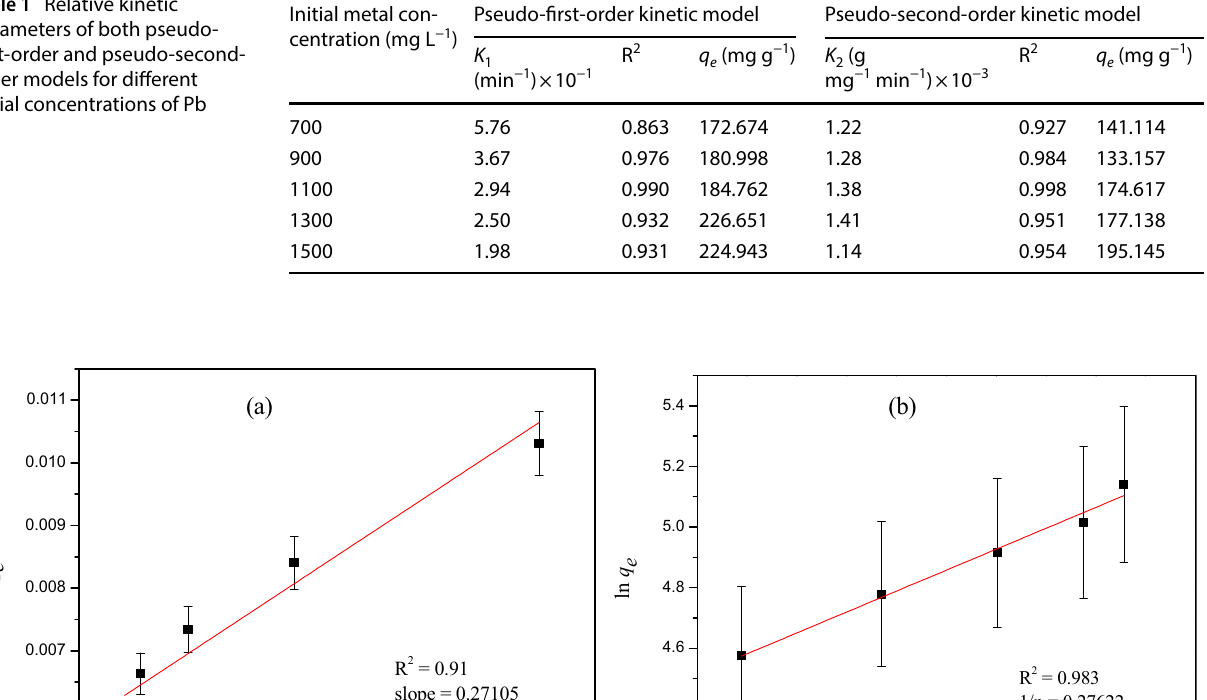
Table 1 Relative kinetic parameters of both pseudo- first-order and pseudo-second- order models for different